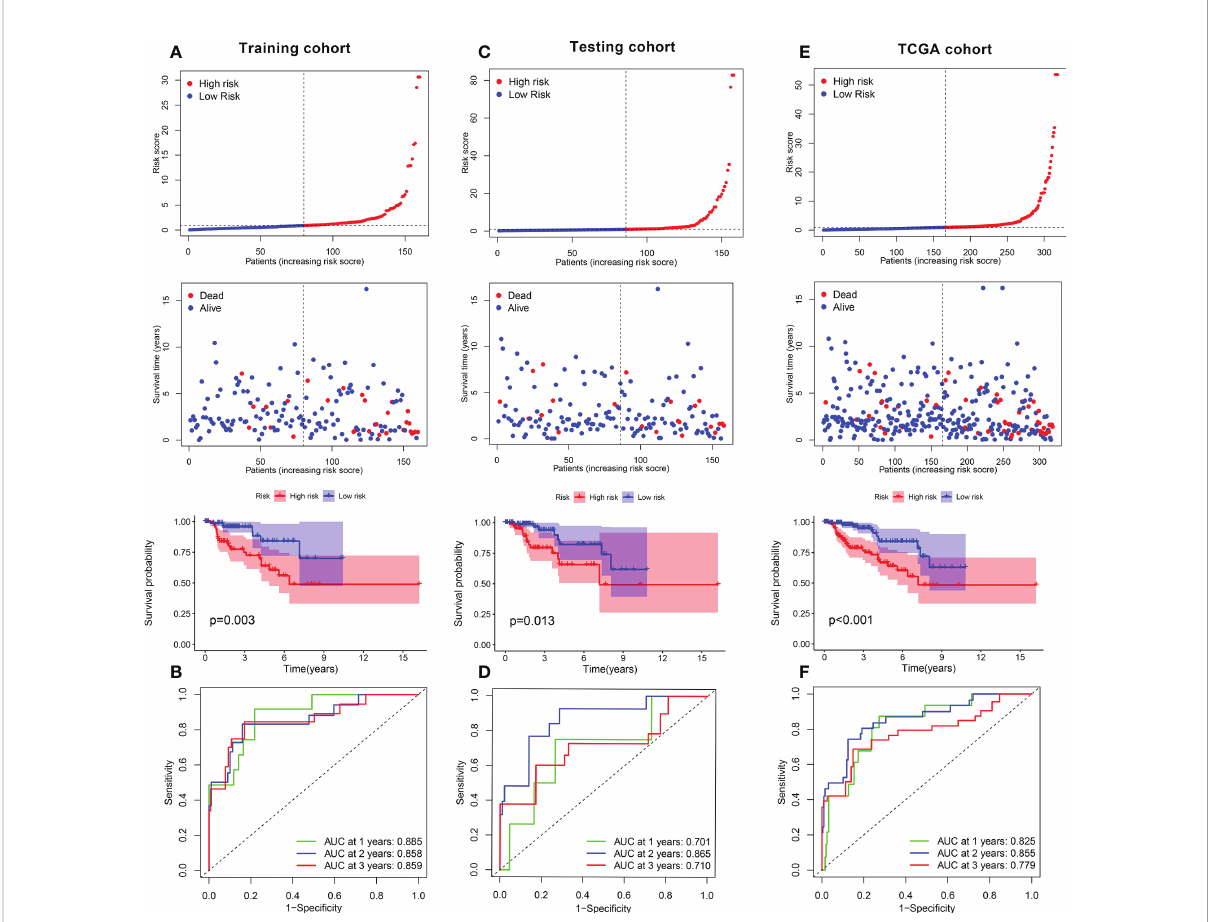
FIGURE 4 Role of FRGPI in prognosis for KIRP. (A, C, E) Risk score and Kaplan – Meier curve in the low- and high-risk groups comprising patients with KIRP from the training, testing and TCGA cohorts. (B, D, F) ROC curves to evaluate the predictive ef fi ciency of FRGPI at 1, 2 and 3 years in the training, testing and TCGA